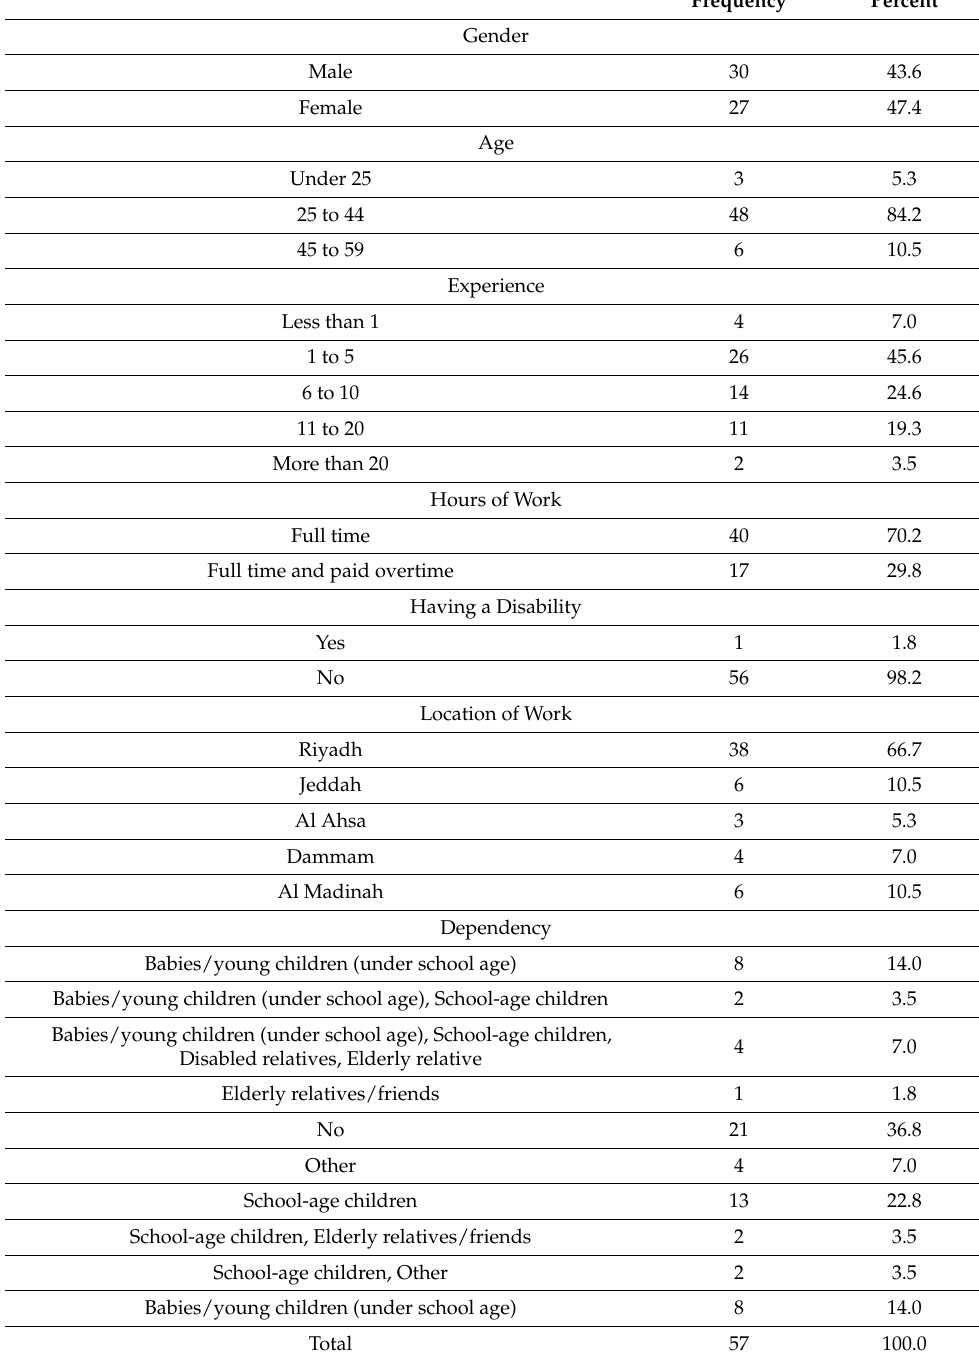
Table 1. Sociodemographic Characteristics of